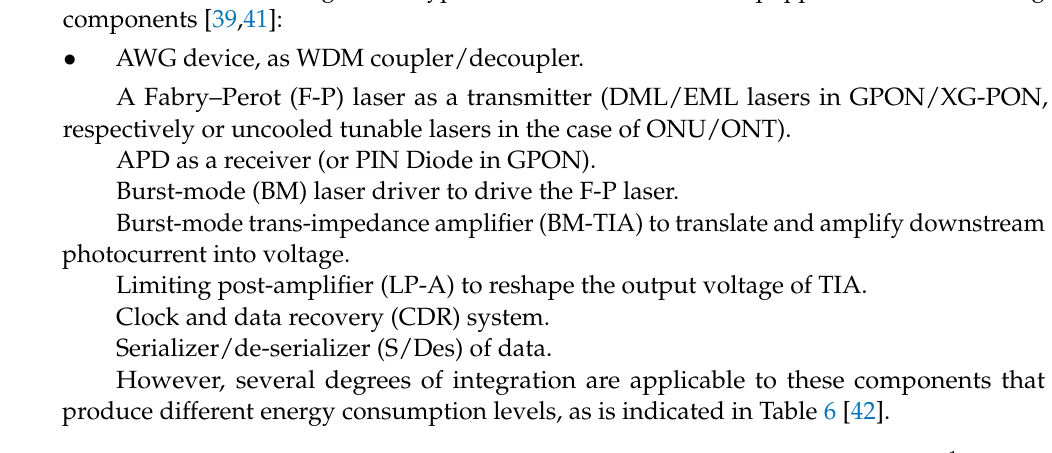
Figure 10. ONU/ONT Energy Consumption (basic modes) in arbitrary units. As it is shown in Figure 9, a typical OLT or ONU/ONT is equipped with the following